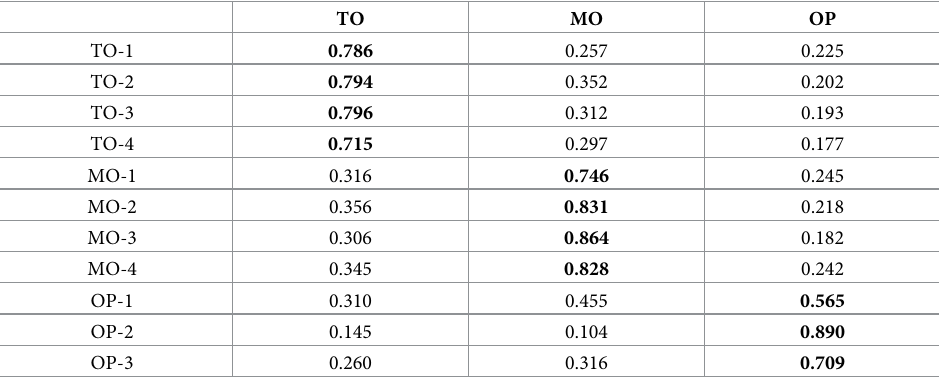
Table 5. Results of